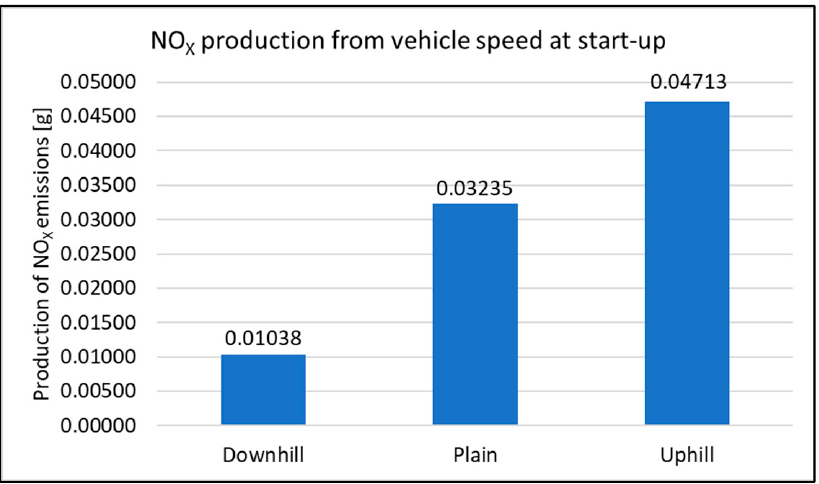
Figure 9. NO X production at start-up.